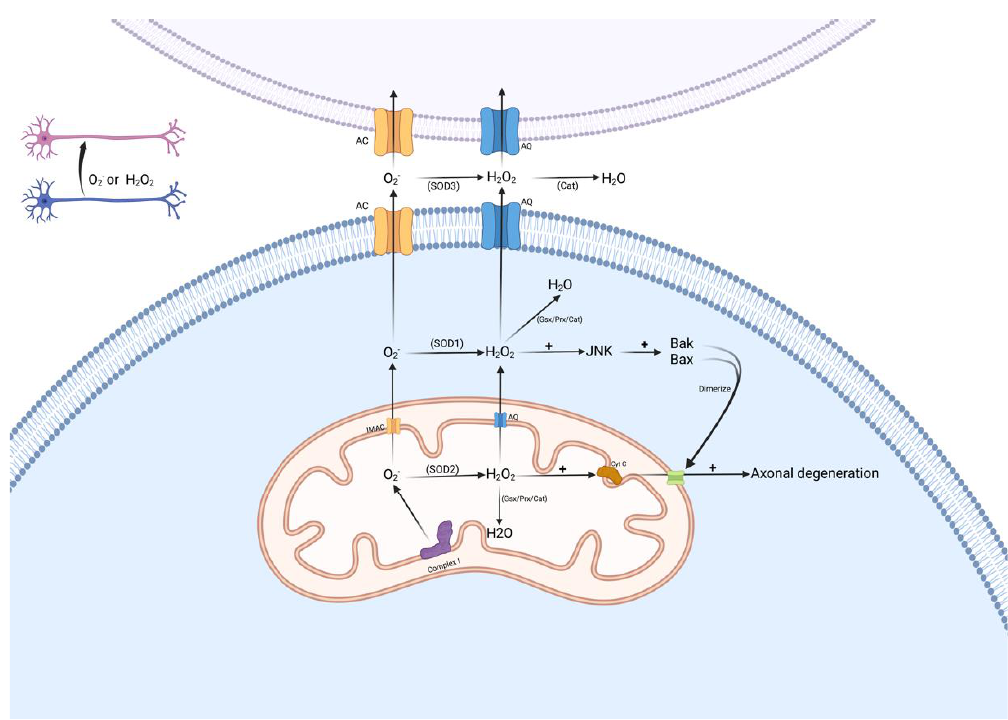
Figure 1. The biochemical model uses two ROS species, O 2 – and H 2 O 2. Mitochondria are considered the main source of O 2 – . The dismutation of O 2 – results in H 2 O 2 . While there are other H 2 O 2 sources, the current study explores only the effects of H 2 O 2 produced from O 2 – . Facilitated diffusion of H 2 O 2 is conducted through aquaporin (AQ) channels. Low quantities of O 2 – diffuse through anionic channels (AC), such as subsets of chloride-conducting channels.